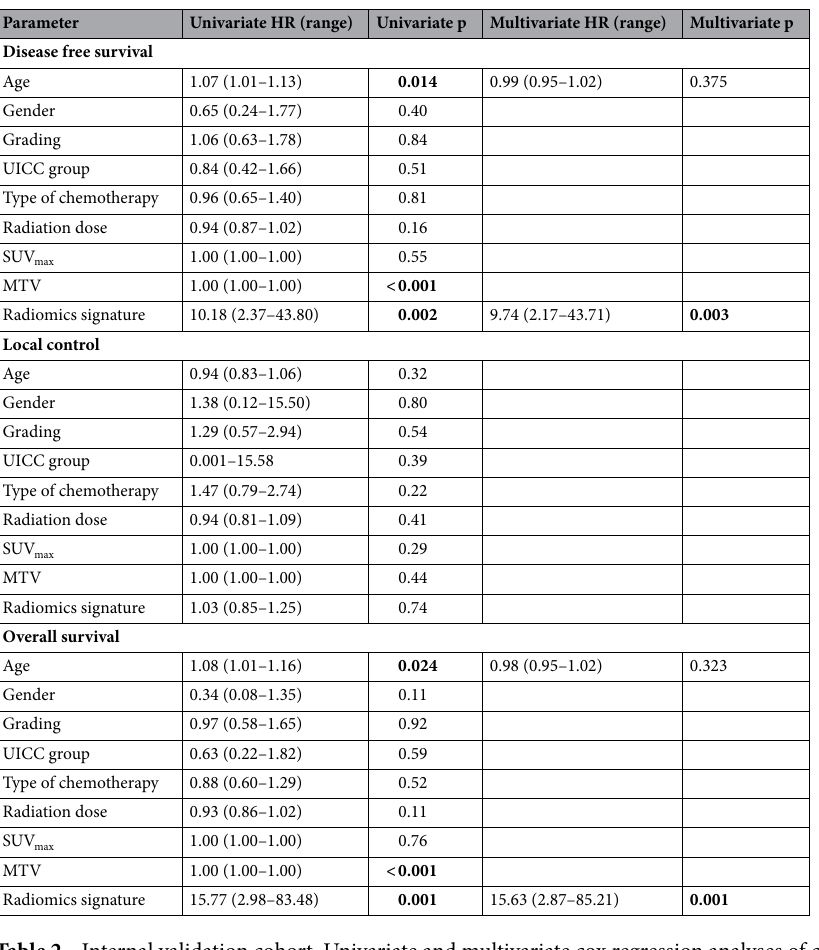
Table 2. Internal validation cohort. Univariate and multivariate cox regression analyses of clinical parameters, treatment characteristics, the conventional PET parameter metabolic tumor volume (MTV) and radiomics signatures with respect to DFS, LC and OS. Due to the high correlation of radiomics signatures and MTV, only radiomic signatures were included in case of multivariate testing.